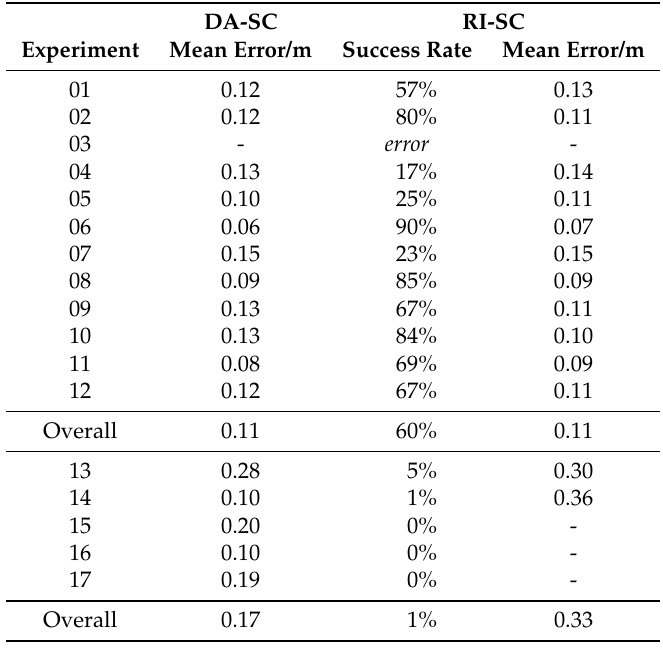
Table 2. Performance comparison between DA-SC and RI-SC in real experiments. The success rates of RI-SC is the percentage of success attempts over 100